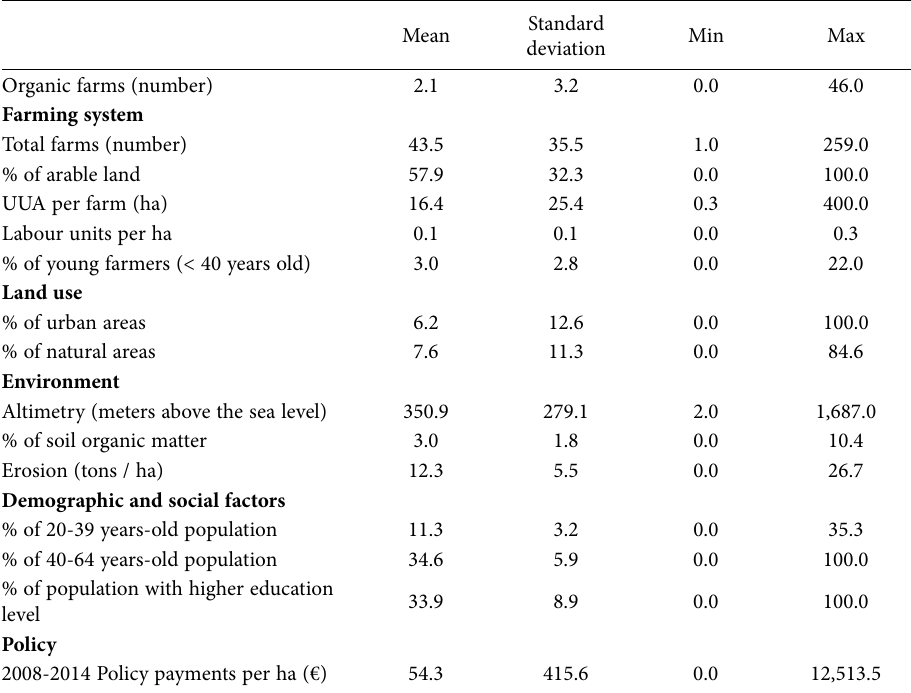
Table 1. Descriptive statistics about the data used based on a regular grid of cells with a 3-km grid size and presence of farmers (total number of observations =